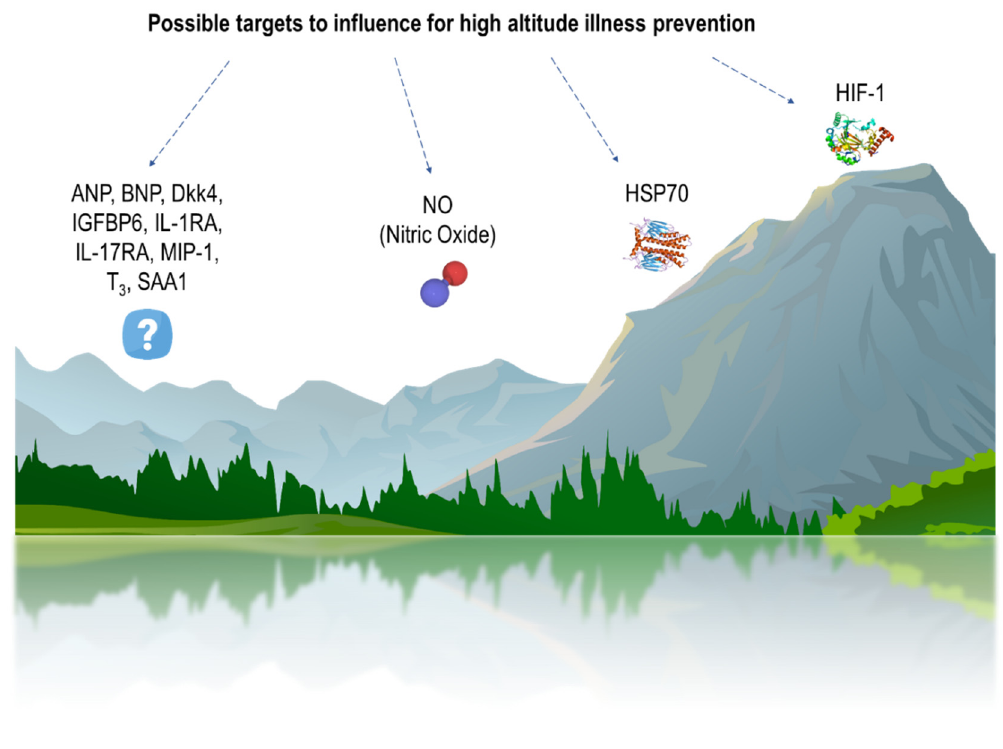
Figure 1. Common biomarkers, revealed both in humans and animals (HIF-1—Hypoxia-Inducible Factor, HSP70—Heat-Shock Protein 70, NO—Nitric Oxide), which are supposed to be responsible for determination of hypoxia tolerance and possible biomarkers, differences in which were demonstrated among humans with different AMS and HAPE tolerance (ANP—Atrial Natriuretic Peptide, BNP—Brain Natriuretic Peptide, Dkk4—Dickkopf WNT signaling pathway inhibitor 4, IGFBP6—Insulin-like Growth Factor Binding Protein 6, IL-1RA—Interleukin 1 Receptor Agonist, IL-17RA—Interleukin 17 Receptor A, MIP-1—Macrophage Inflammatory Protein-1, T 3 , SAA1—Serum Amyloid A1).